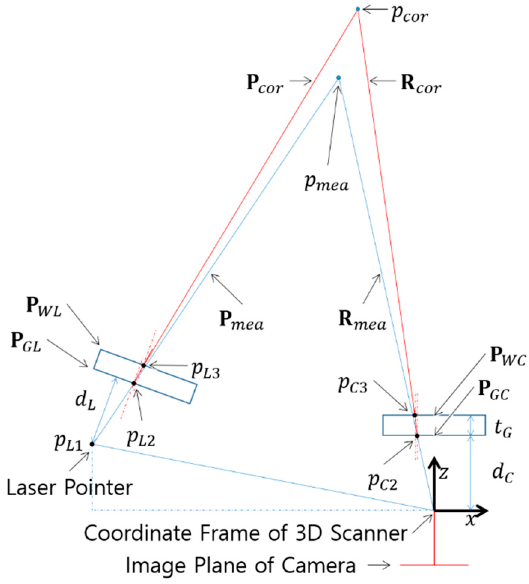
Figure 13. Refraction Model.